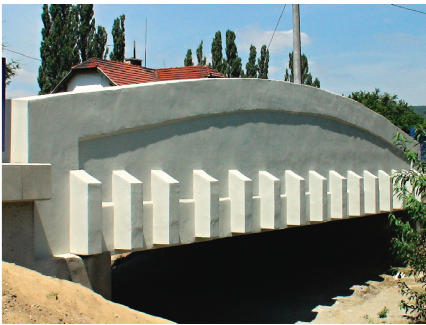
Figure 17: Protection of anchors using additionally cast concrete extensions. An aesthetic solution for anchoring the transverse cables of a U-shaped bridge